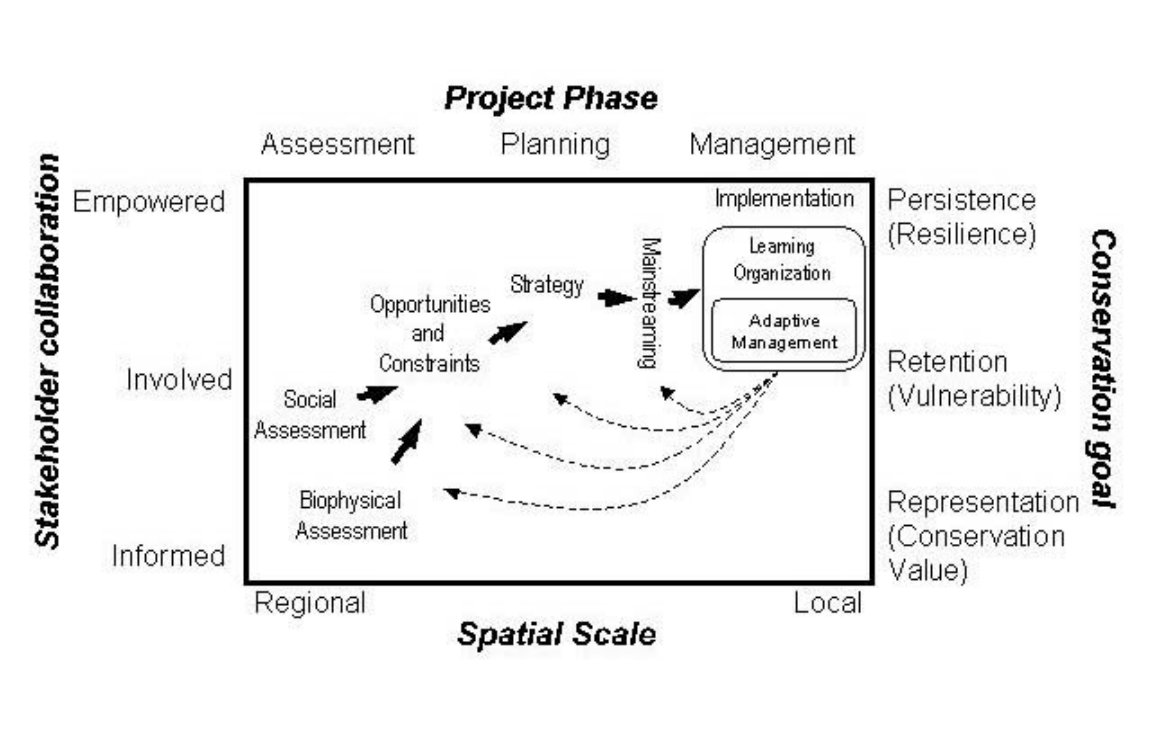
Fig. 1. An operational model for mainstreaming conservation planning products for implementation (after Knight et al. 2006 a , Cowling et al.